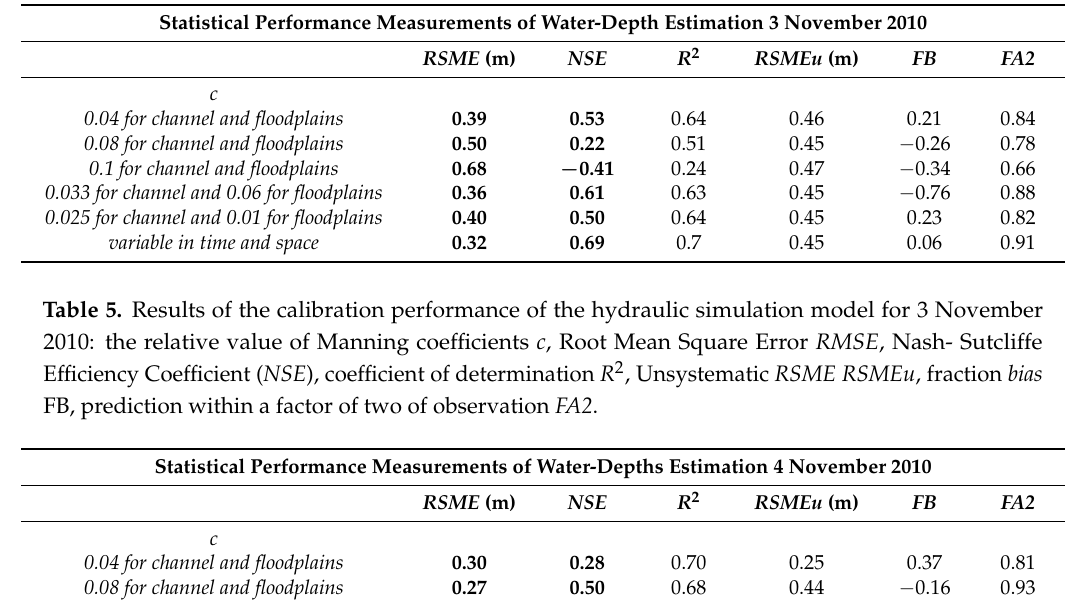
Table 4. Results of the calibration performance of the hydraulic simulation model for 3 November 2010 in terms of water depth: the relative value of Manning coefficients c , Root Mean Square Error RMSE , Nash- Sutcliffe Efficiency Coefficient ( NSE ), coefficient of determination R 2 , Unsystematic RSME RSMEu , fraction bias FB , prediction within a factor of two of observation FA2 .